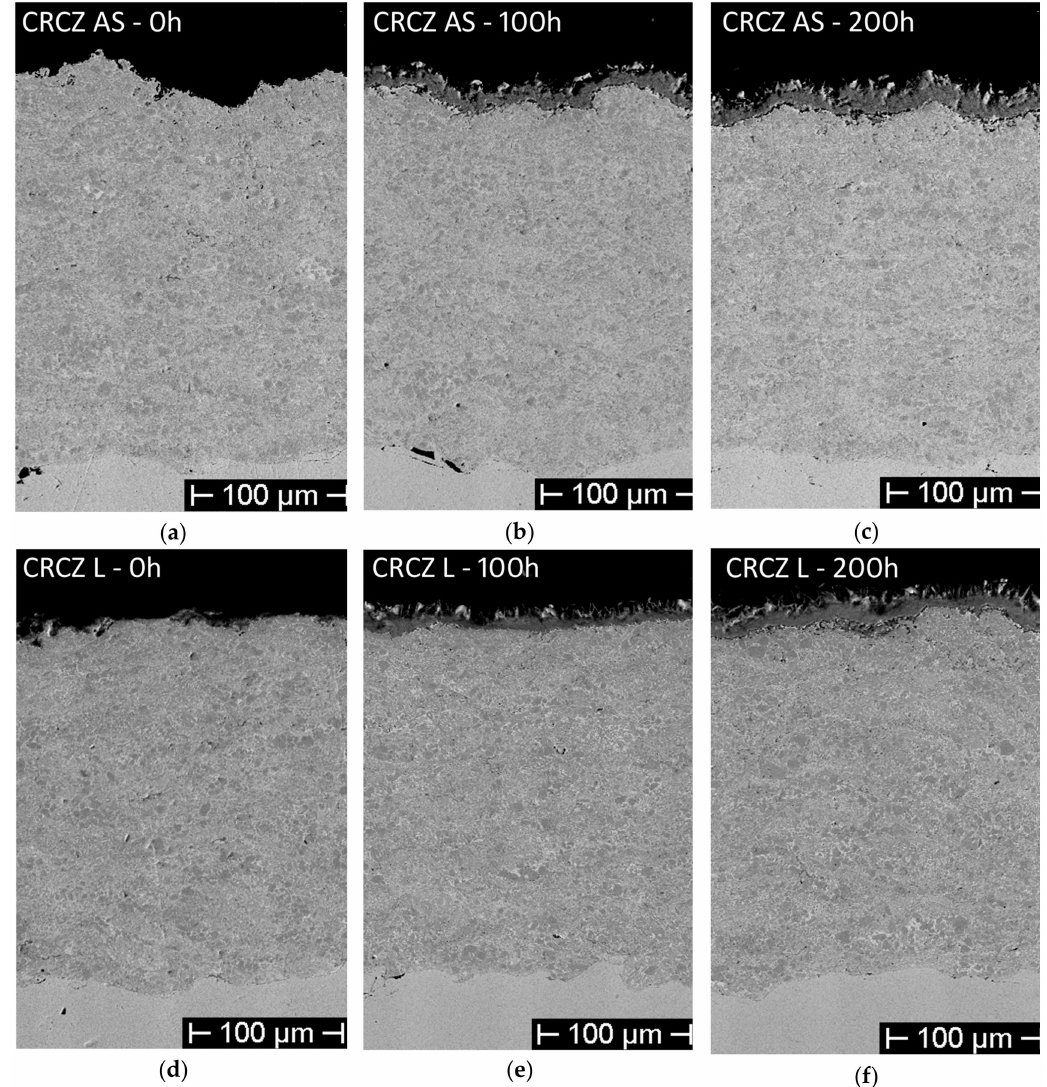
Figure 3. Cross-sections of the CRCZ samples: ( a ) As-sprayed; ( b ) as-sprayed after 100 h of hot corrosion test; ( c ) as-sprayed after 200 h of hot corrosion test; ( d ) laser-treated; ( e ) laser-treated after 100 h of hot corrosion test; and ( f ) laser-treated after 200 h of hot corrosion